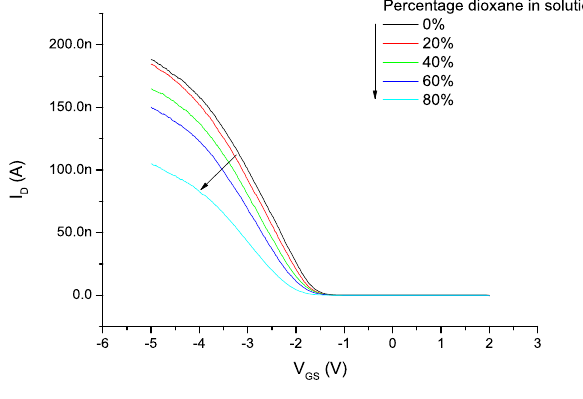
Figure 4. I - V characteristics of a single nanowire device when exposed to the different D GS water − dioxane mixtures. An Ag/AgCl electrode was used as liquid gate in this experiment.